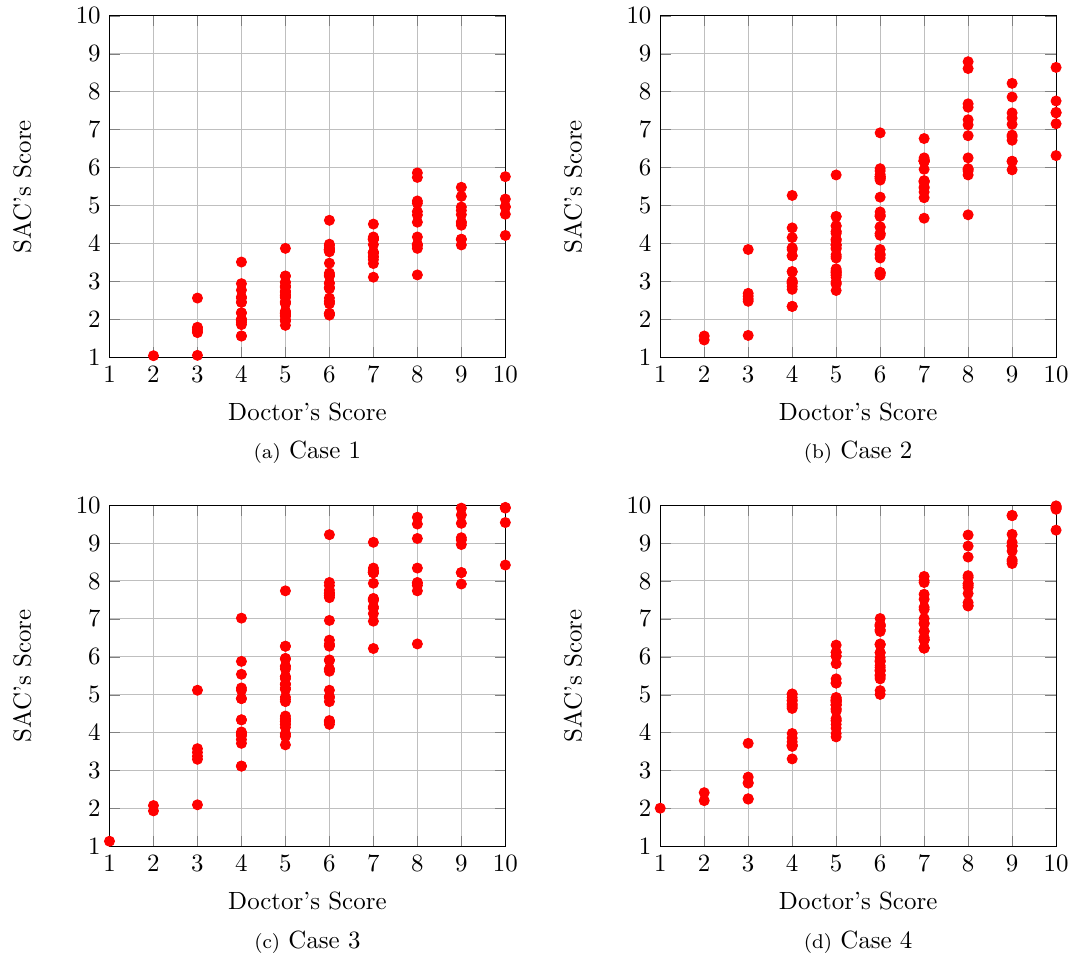
Figure 7. The comparison of statistical plots of SAC’s score vs. doctor’s score under different α , f A , f B , and f C ; ( a ) α = 1, f A = 0.6, f B = 0.25, and f C = 0.15; ( b ) α = 1.45, f A = 0.6, f B = 0.25, and f C = 0.15; ( c ) α = 1.68, f A = 0.6, f B = 0.25, and f C = 0.15; and ( d ) α = 1.53, f A = 0.63, f B = 0.22, and f C =